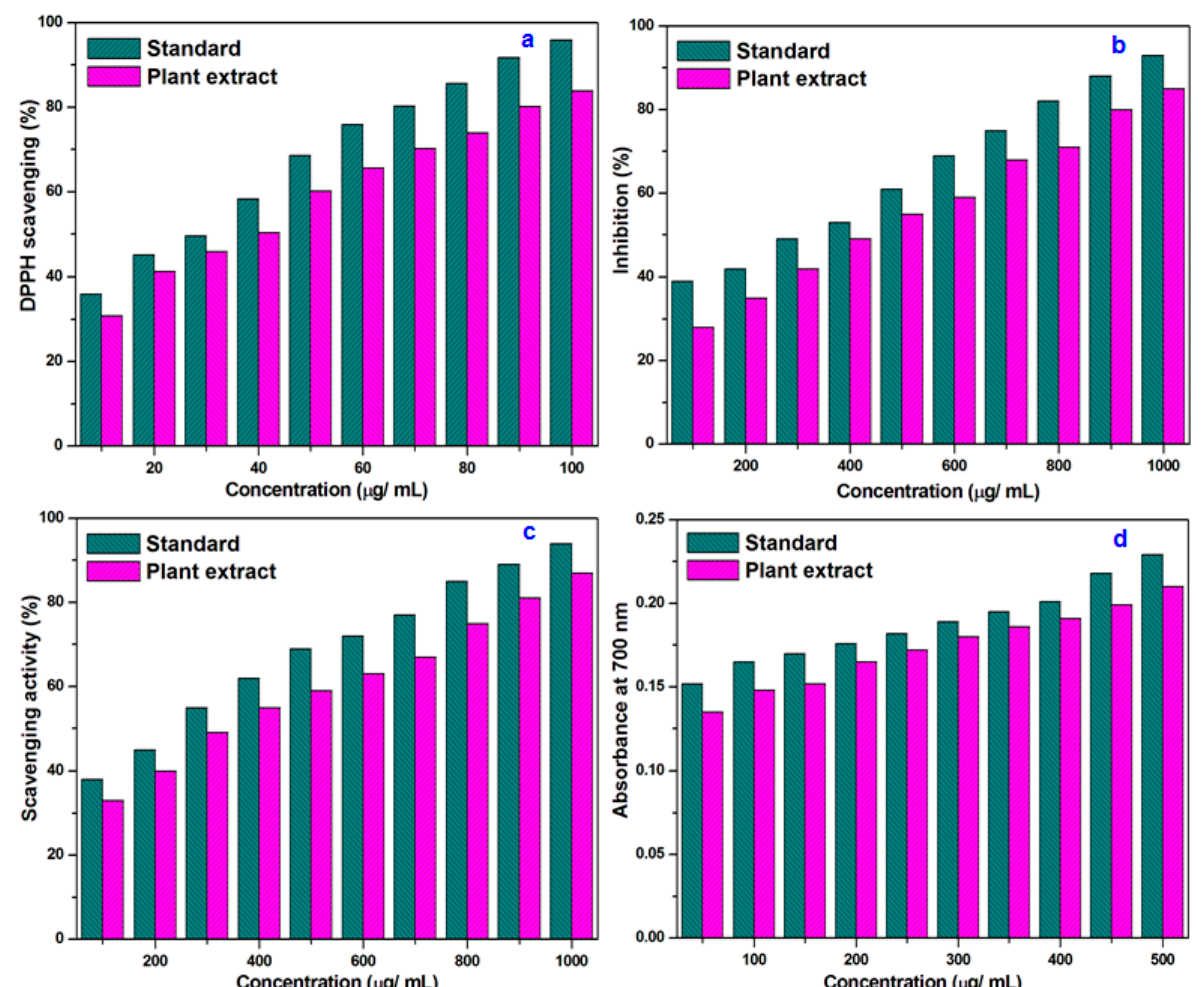
Figure 3. Antioxidant activities of C. tagal : ( a ) DPPH free-radical scavenging; ( b ) nitric oxide inhibition; ( c ) hydrogen peroxide free-radical scavenging; ( d ) reducing power.